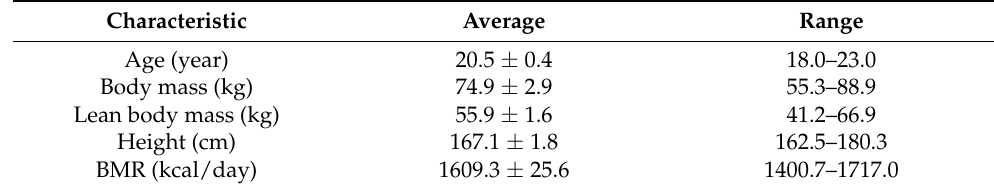
Table 1. Average anthropometric characteristics and basal metabolic rate (BMR) of the participants.